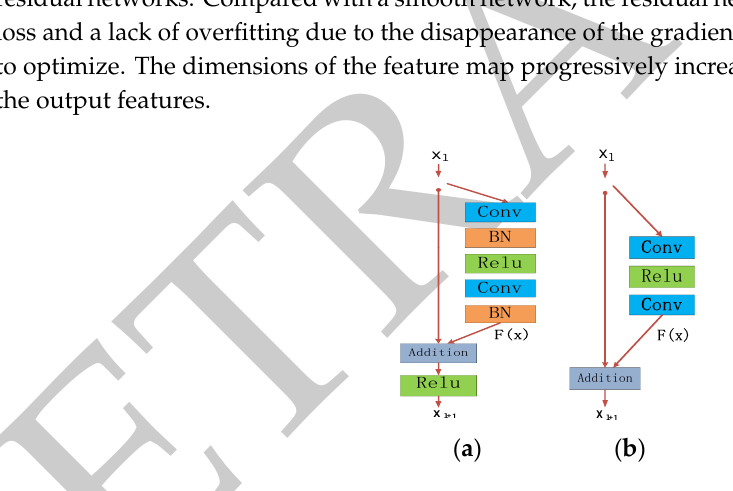
Figure 3. The processing construction with improved residual blocks described in the paper. ( a ) Original Residual Blocks; ( b ) Improved Residual Blocks in the